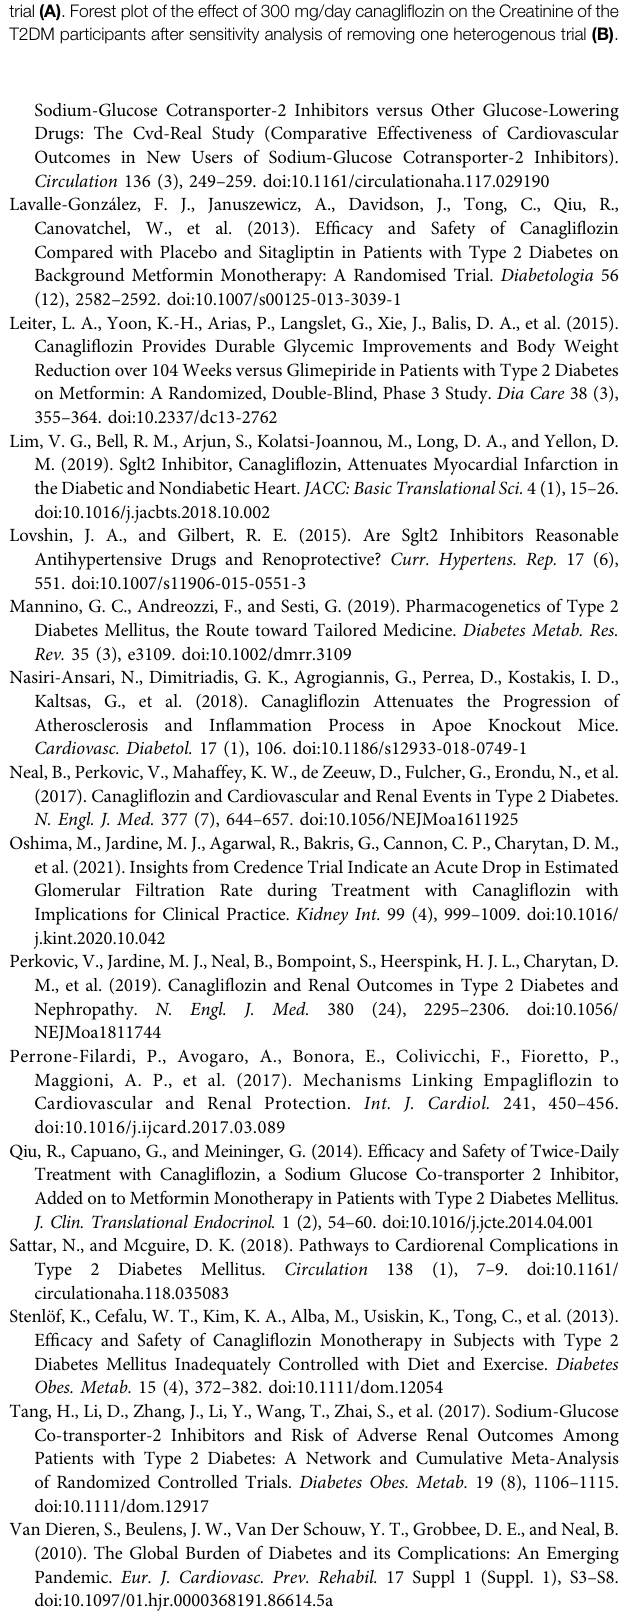
trial (A) . Forest plot of the effect of 300 mg/day canagli fl ozin on the Creatinine of the T2DM participants after sensitivity analysis of removing one heterogenous trial (B)